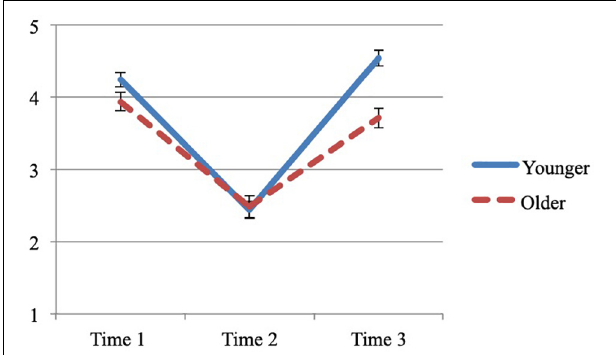
FIGURE 4 | Study 3 mood improvement by time and age